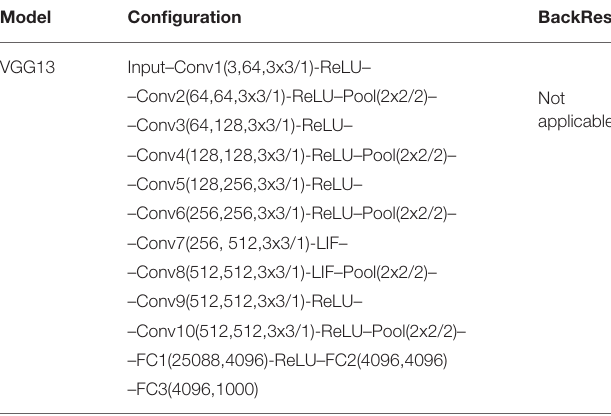
TABLE 17 | Network topologies for AGD training methodology with hybrid layers and softmax classifier at the end for imagenet